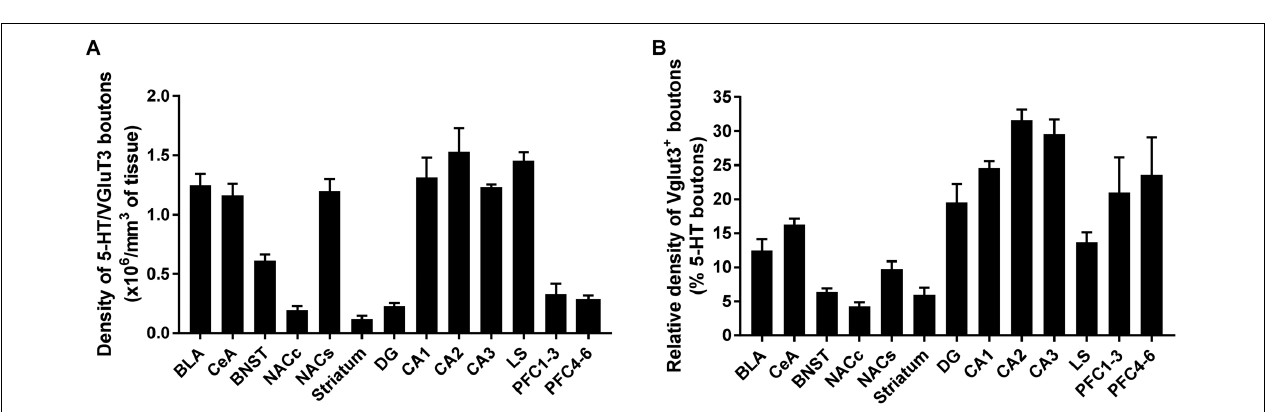
FIGURE 7 | Distribution of VGLUT3 + boutons within 5-HT + and SERT + axons in the CA1, CA2, CA3, dentate gyrus of the hippocampus. (A) Schematic drawing showing the location of the acquired micrographs. The hippocampus (HIP) mosaic images were acquired at bregma –1.70 ± 0.3 mm (red vertical line) in the dorsal hippocampus (green/red area). (B) Micrograph showing the distribution of the SERT (green, a–c”’ ), 5-HT (red, d–f”’ ), SERT (green) + 5-HT (red) ( g–i”’ ), and VGLUT3 (magenta, j–l”’ ) in the CA1, CA2, CA3, and DG. Left panel (a,d,g,j) shows lower magnification. Scale bar: 150 µ m. Right panels show higher magnification of the CA1 (b–l) , CA2 (b’–l’) , CA3 (b”–l”) , and DG (b”’–l”’) in the white dashed box in the left panel (a,d,g,j) . Scale bar: 2 µ m. The right panel shows the VGLUT3 boutons co-labeled with SERT (c–c”’) , 5-HT (f–f”’) , and SERT + 5-HT (i–i”’) . VGLUT3 puncta located within 5-HT varicosities were isolated using Imaris in the CA1 (l–l”’) . Arrowheads show 5-HT varicosities collocated with SERT and VGLUT3 in the CA1 ( c–c”’, f–f”’, i–i”’, and l–l”’ ). (C:a–d) Quantification of the proportion of 5-HT varicosities not co-labeled (SERT - ) and co-labeled (SERT + ) with SERT in the CA1 (a) , CA2 (b) , CA3 (c) , and DG (d) of the HIP, showing a great majority of 5-HT varicosities co-labeled with SERT. (e–h) Quantification of the proportion of 5-HT + /VGLUT3 + not co-labeled (SERT - ) and co-labeled (SERT + ) with SERT in the CA1 (e) , CA2 (f) , CA3 (g) , and DG (h) of the HIP, showing a great majority of 5-HT + /VGLUT3 + varicosities co-labeled with SERT ( t -test, ∗∗∗∗ p < 0.0001; ∗∗ p < 0.01).